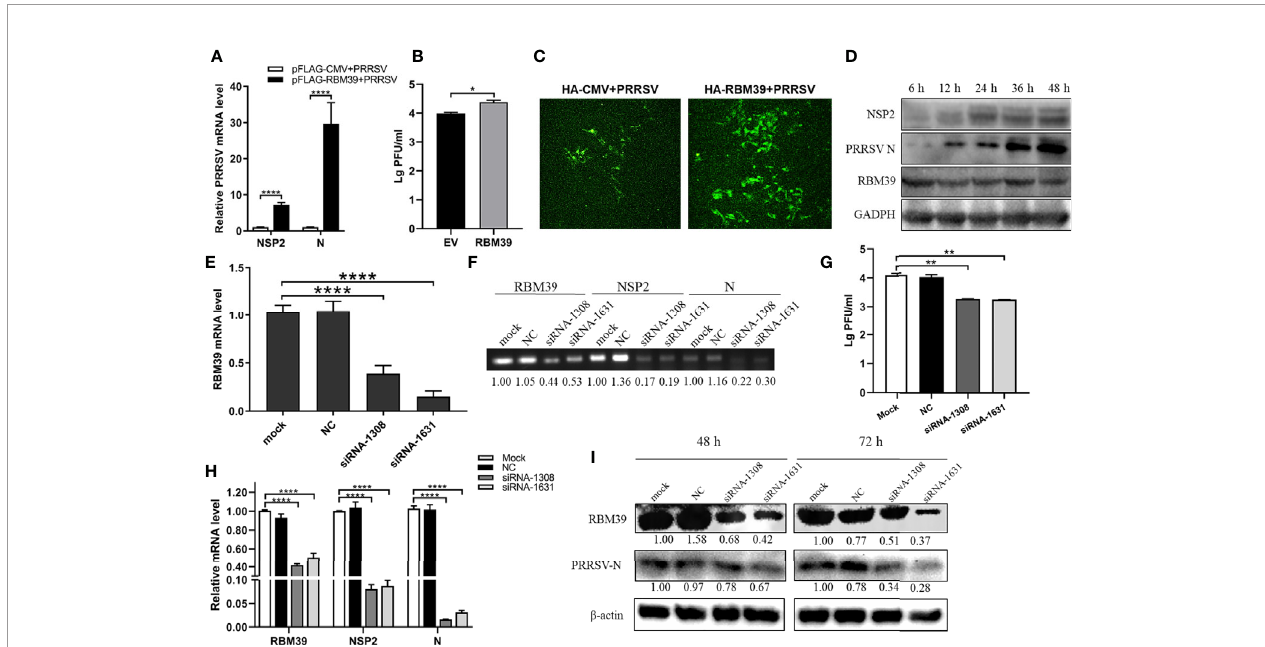
FIGURE 2 | RBM39 contributes to PRRSV proliferation. (A – D) 3D4/21 cells were transfected with Flag/HA-RBM39 or empty vector and infected with PRRSV at 12 h post-transfection. The infected cells were collected at the indicated times post-infection. (A) The mRNA loads of PRRSV N and nsp2 were tested by qRT-PCR. Detection of viral titers of PRRSV in cell supernatants of RBM39 overexpressed (B) or interfered (G) samples. (C) The cell slide was incubated overnight at 4°C with the antibody of PRRSV N and then incubated with FITC – labeled secondary antibody conjugate. The expression of PRRSV N was detected by Laser confocal fl uorescence microscope. (D) PRRSV nsp2 and N protein expression were tested by WB. (E – I) The results showed 3D4/21 cells transfected with siRNA of RBM39, negative control (NC) or untransfected mock cells. The cells were infected with PRRSV at 12 h post-transfection and collected at 24 h post-infection. The mRNA levels of RBM39 (E, H) , PRRSV N and nsp2 (H) were detected by qRT-PCR. (F) The agarose gel electrophoresis analysis after qRT-PCR. (I) RBM39 and PRRSV protein expression levels were examined by Western blot after 48 or 72 h. Data are representative of results from three independent experiments. The statistically signi fi cant at P-value was demonstrated in Statistical Analysis